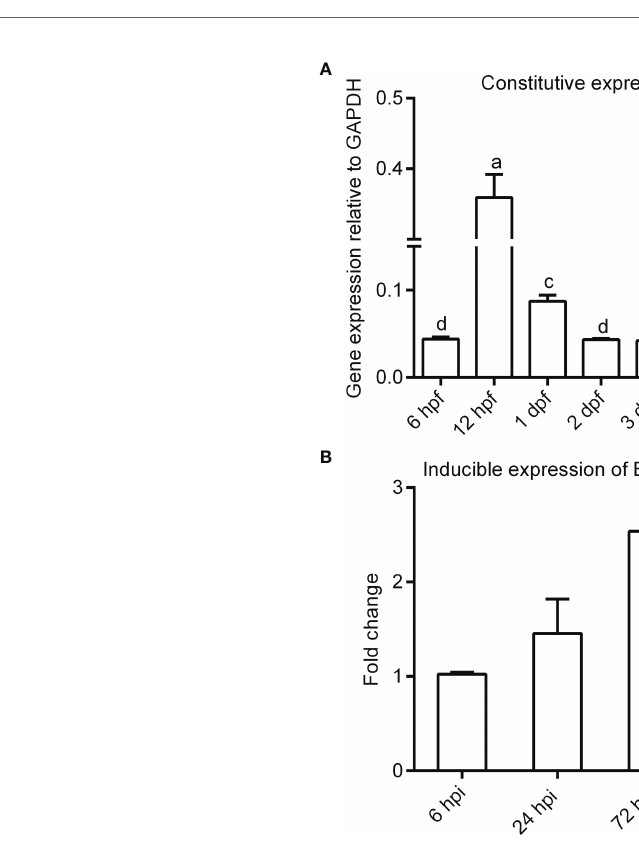
FIGURE 2 | The expression patterns of zebra fi sh BIRC2. (A) The constitutive expression of zebra fi sh BIRC2 in zebra fi sh embryos and larvae. Means with different letters are statistical different. (B) The inducible expression of zebra fi sh BIRC2 in zebra fi sh larvae infected with E. piscicida . Data represented the means ± the SEM (n = 3) and were tested for statistical signi fi cance using a two-tailed student ’ s t- test or one-way ANOVA. ** p <